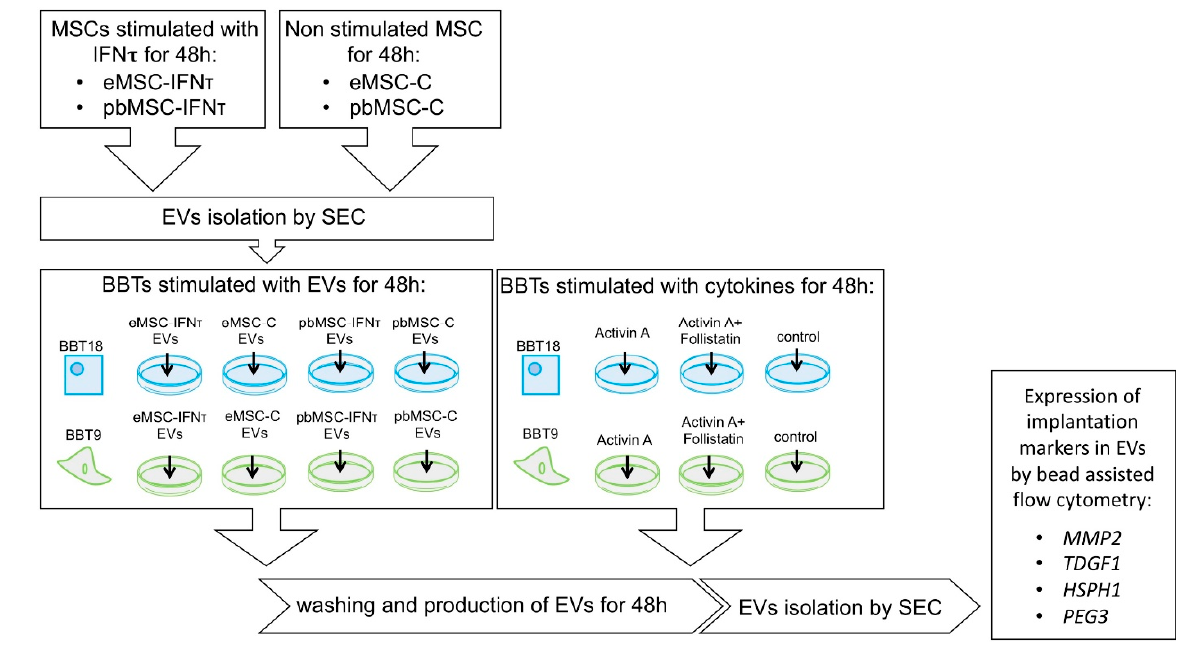
Figure 5. Experimental design.